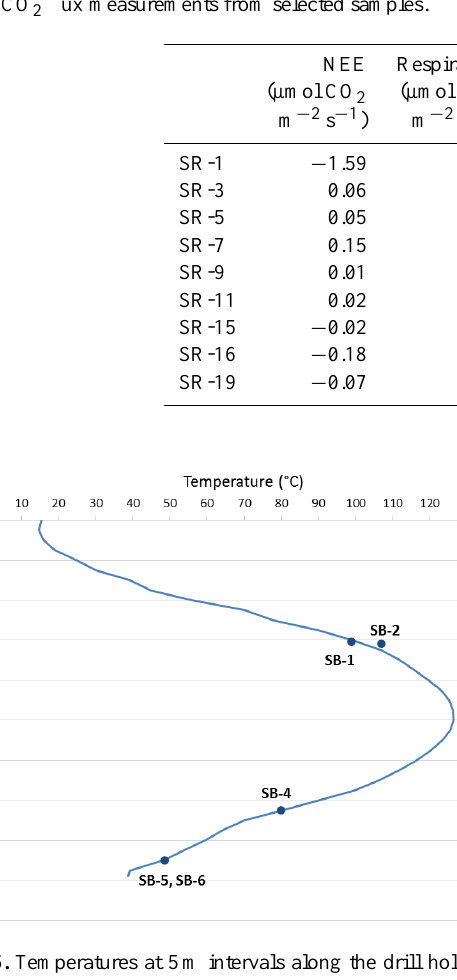
Table 2. CO 2 flux measurements from selected samples.